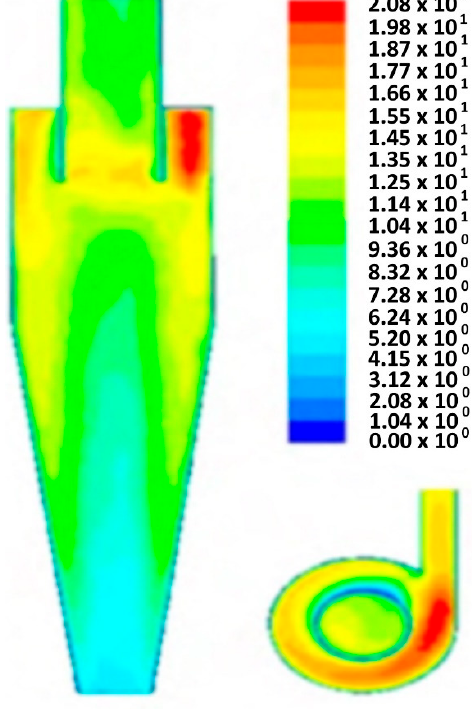
Figure 7. Velocity magnitudes [19].